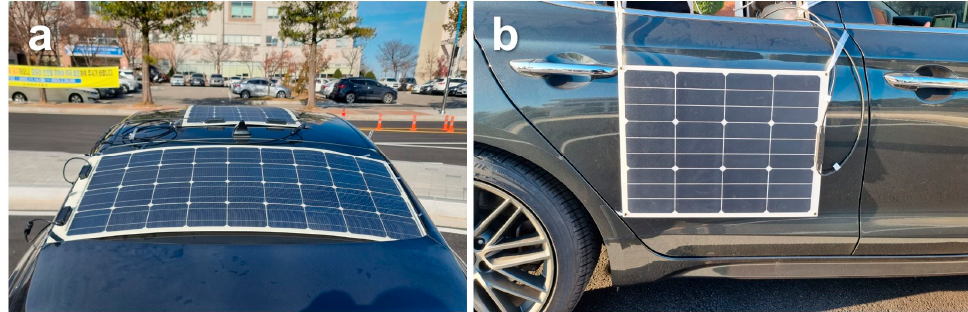
Figure 4. PV modules attached on the car for field experiment. ( a ) Modules A and B, ( b ) module